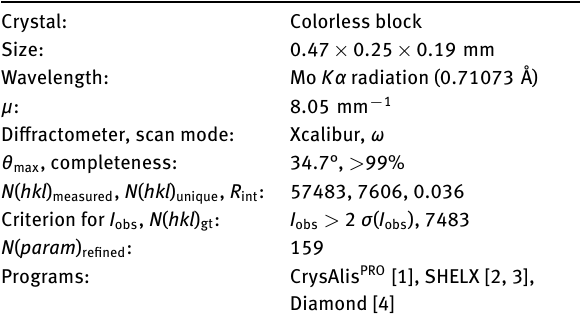
Table 1 contains crystallographic data and Table 2 con- tains the list of the atoms including atomic coordinates and displacement parameters.